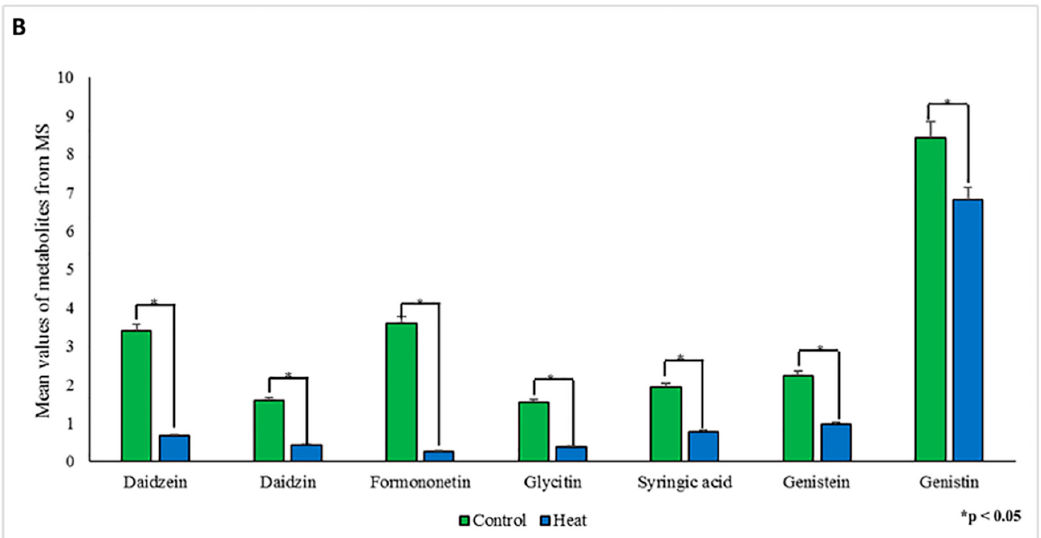
Figure 7. Effect of drought and heat stress on secondary metabolites. ( A ) Heat map showing differential expressions of various secondary metabolites during drought and heat stress compared to the control treatment. ( B ) Bar diagram showing relative expression of various phytochemicals in response to heat stress (blue) compared to the control (green). Various phytochemicals are shown on the X -axis, and the Y-axis has the scaled intensity of the respective phytochemical. Each value represents the mean ± S.E., and the asterisks designate the significance of changes from their corresponding control ( p < 0.05).